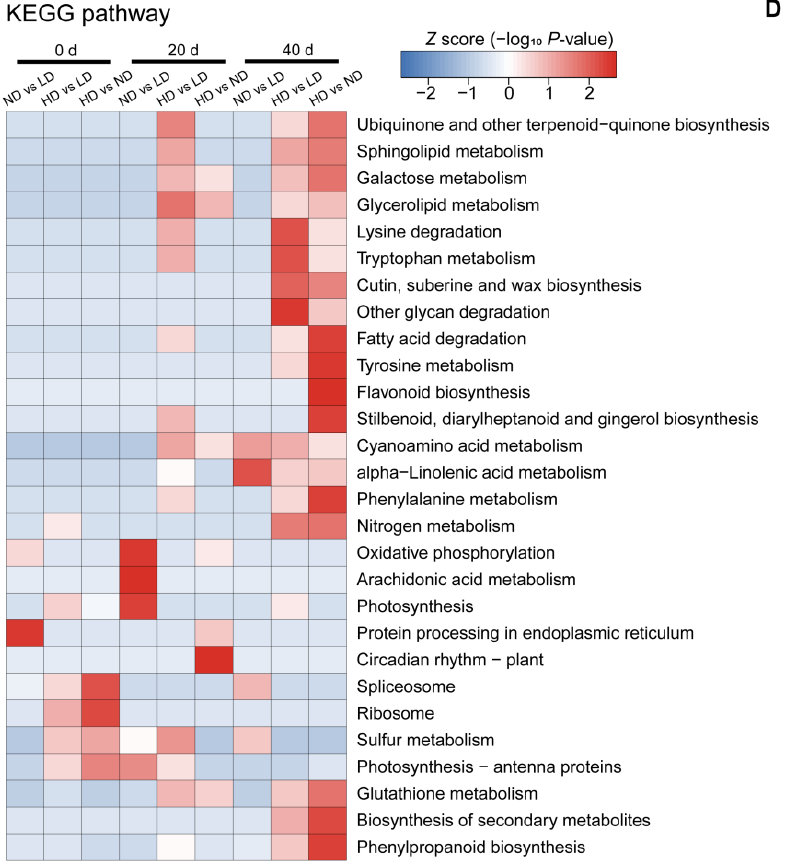
Figure 7. Heatmaps obtained from GO and KEGG pathway analysis comparing the differentially abundant protein (DAP) expression patterns under different conditions. ( A ) Biological process analysis; ( B ) cellular component analysis; ( C ) molecular function analysis; and ( D ) KEGG pathway analysis. Colored scales of the Z score ( – log 10 p -value) are shown; proteins that accumulated at high levels are in red, and proteins with low accumulation levels are in blue. LD, low density; ND, normal density; HD, high density; 0, 20, and 40 d, days after anthesis.